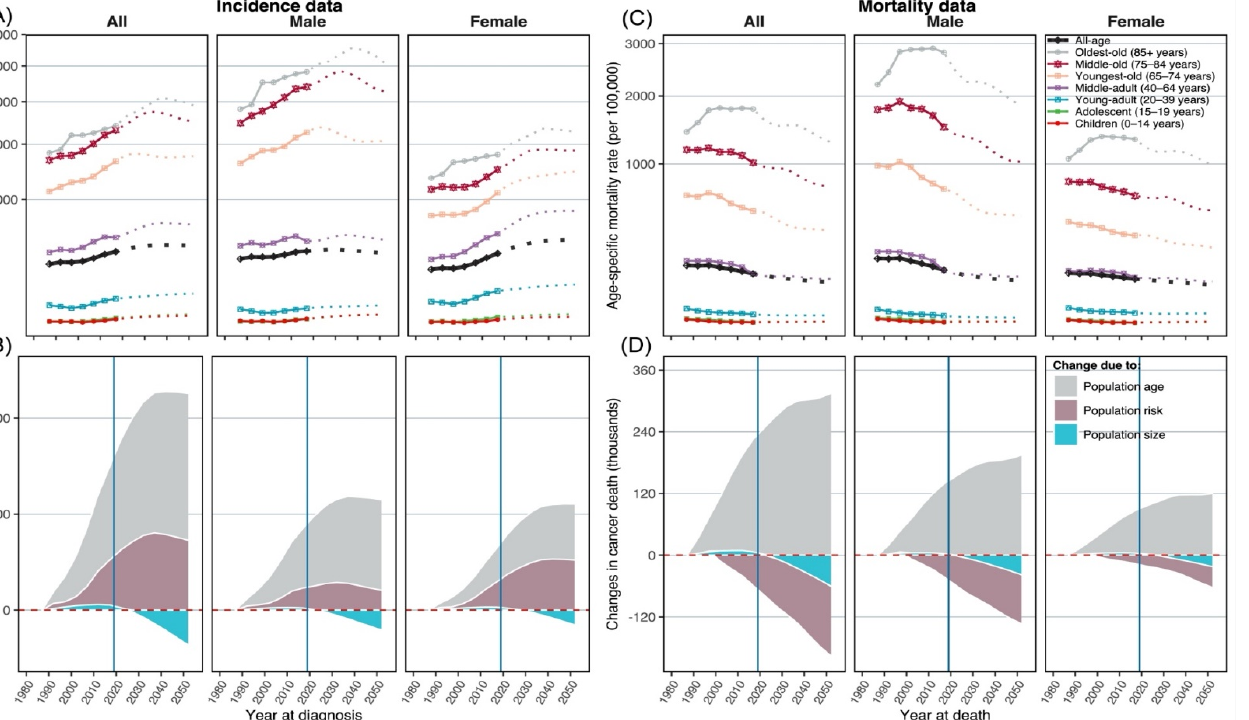
Figure 1. Projections of age ‐ specific incidence rates (Panel ( A )) and mortality rates (Panel (C )), and decomposed changes in new cancer cases (Panel ( B )) and deaths (Panel ( D )). Notes: Log scales were applied to the Y ‐ axis; in panels ( A, C ), solid lines describe the observed rates, and dotted lines describe the projected rates; in panels ( B, D ), period 1980–1985 was used as a ref ‐